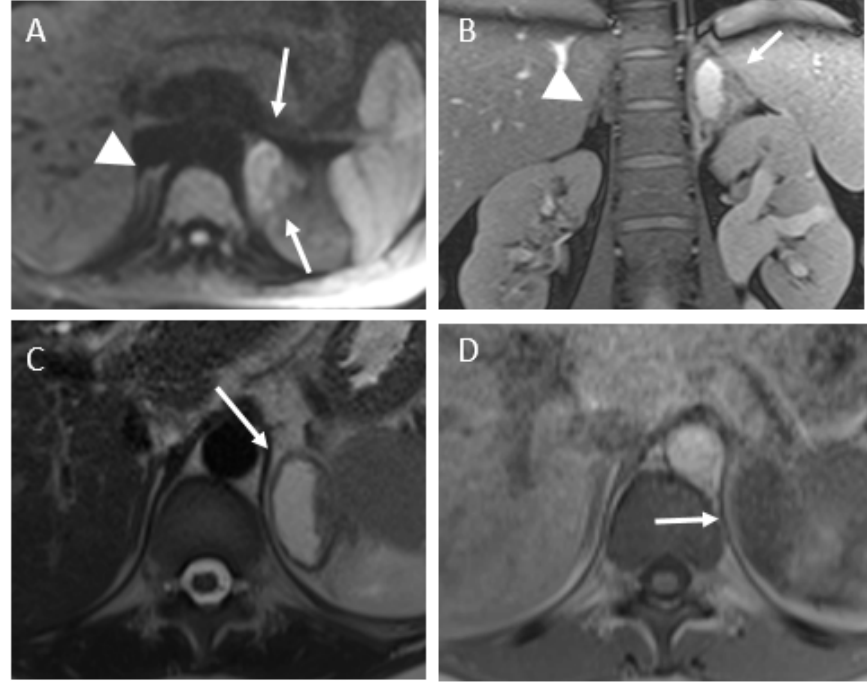
Figure 5. MRI findings of patient 3. ( A ) Diffusion-weighted MR imaging (b800) showing restricted diffusion of the adrenal gland (arrow). No abnormality of the contralateral gland (arrowhead). ( B , C ) Coronal and axial T2-weighted imaging, showing a fluid collection (arrow) beside the swollen left adrenal gland. The left hydronephrosis is chronic (history of urinary stones). ( D ) Axial unenhanced T1-weighted image, showing no hyperintensity of this fluid collection.